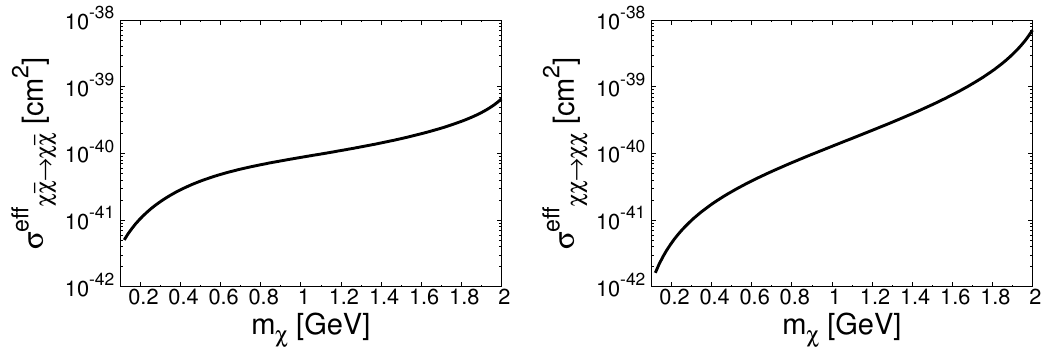
Figure 7 . The cross sections (cid:27) e(cid:11) (cid:21) (cid:30) = 0 : 04, m ~ (cid:31) = 2 GeV, m (cid:30) = 0 : 1